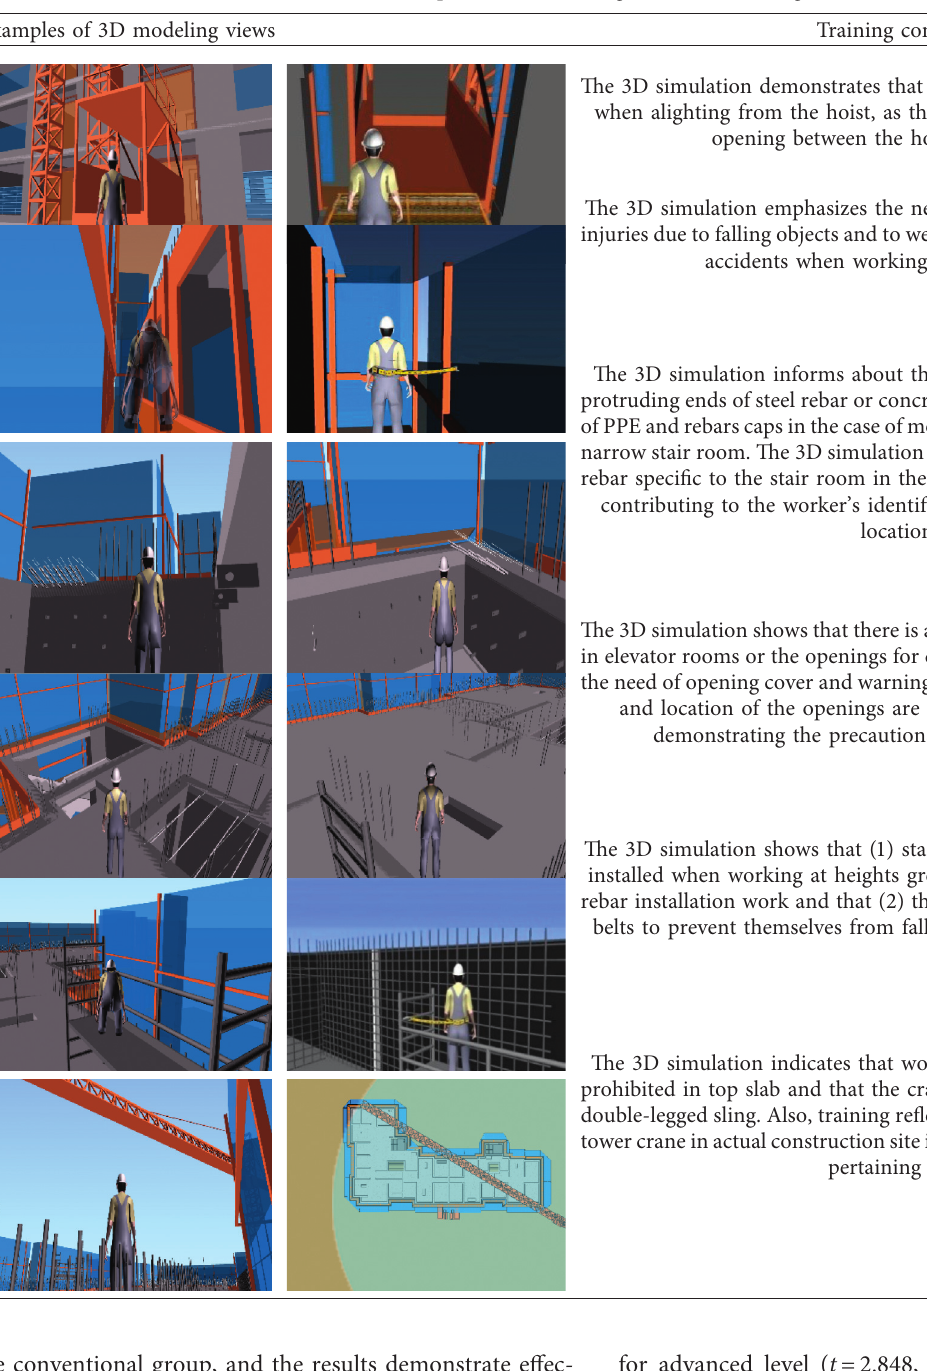
Table 1: Examples of 3D modeling views and training